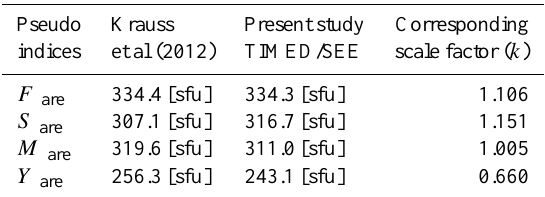
Table 1. Average and maximum values of the different solar in- dices and the integrated intensity flux measurements [25–92nm] by TIMED/SEE.